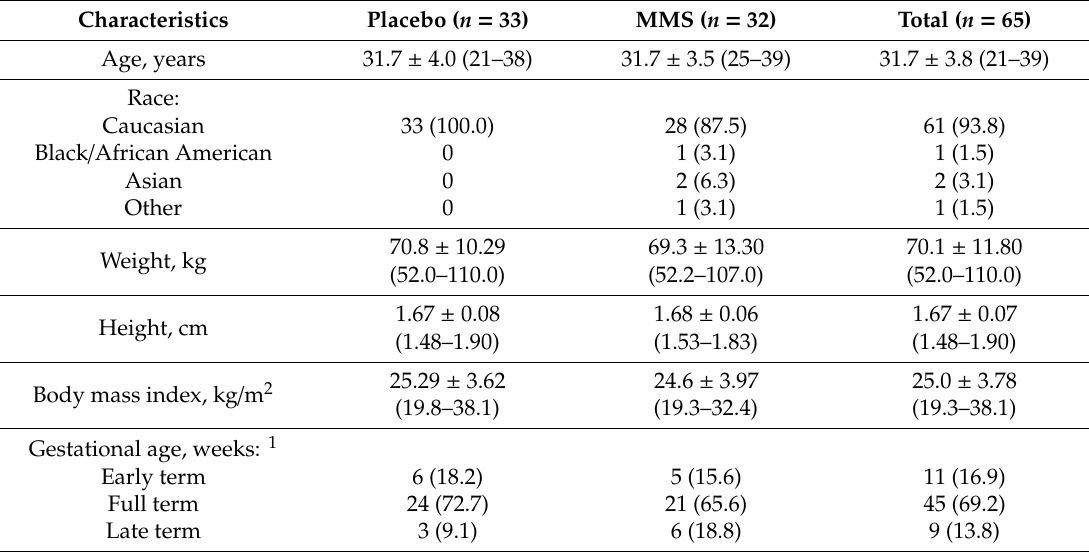
Figure 2. Flow diagram for study participants. ITT, intention-to-treat; MMS, multiple micronutrients, lutein, and docosahexaenoic acid (DHA) supplementation. Table 1. Subject characteristics at baseline and delivery information (per protocol